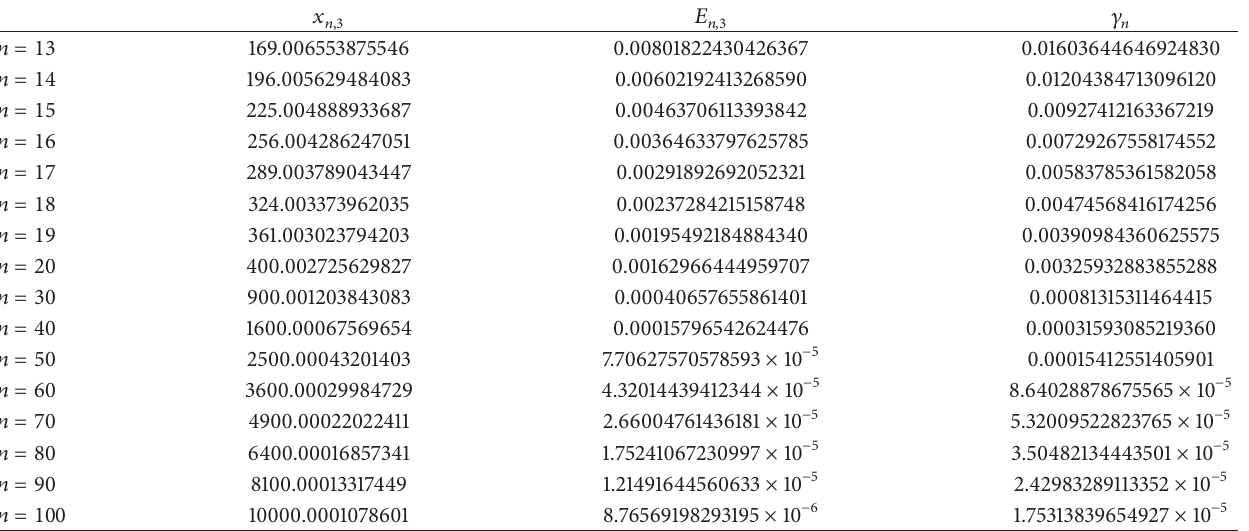
Table 2: Estimations for 𝑇(𝑝 2 ) .